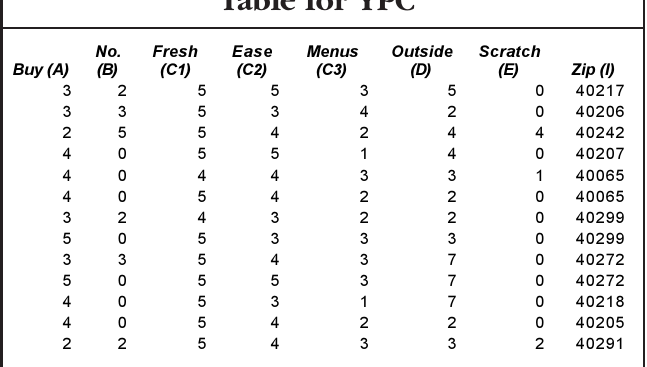
Table 1. Sample Listing of Survey Data Table for YPC